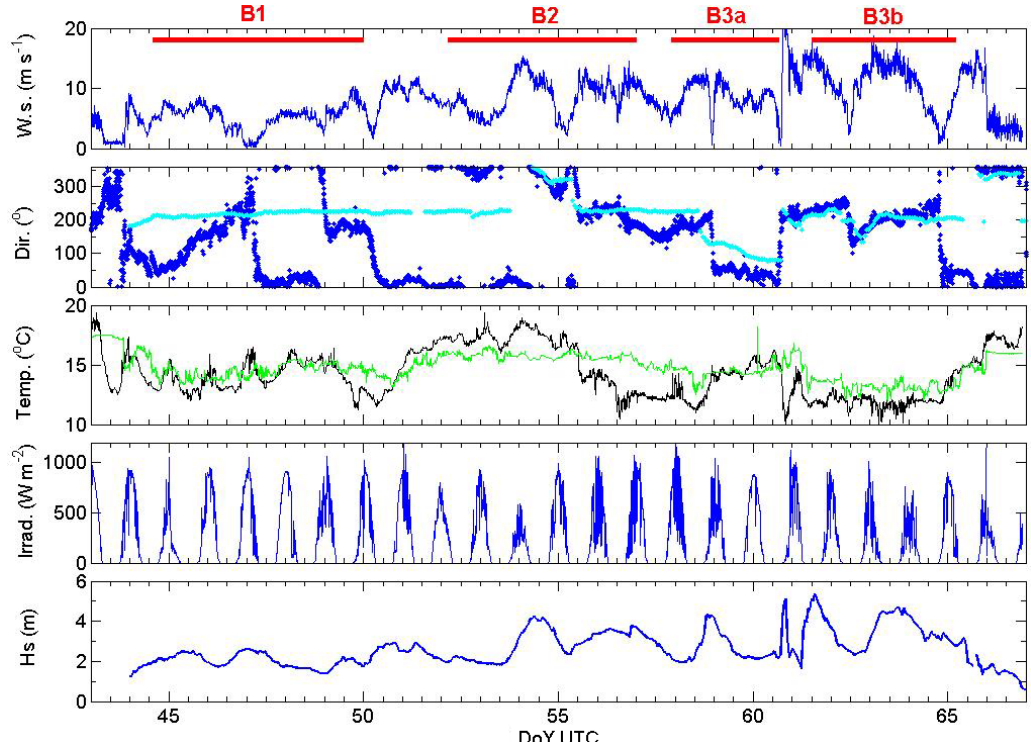
Figure 6. Meteorological and hydrodynamic variables during the SOAP voyage, including (a) wind speed (W.s., ms − 1 ) ; (b) direction (Dir., ◦ ); wind (blue) and wave (cyan); (c) temperature (Temp., ◦ C); air (black) and surface water (green); (d) irradiance (Irrad., Wm − 2 ) and (e) significant wave height ( H s , m). Bloom occupation periods are indicated by the red horizontal bars and bloom labels in the upper